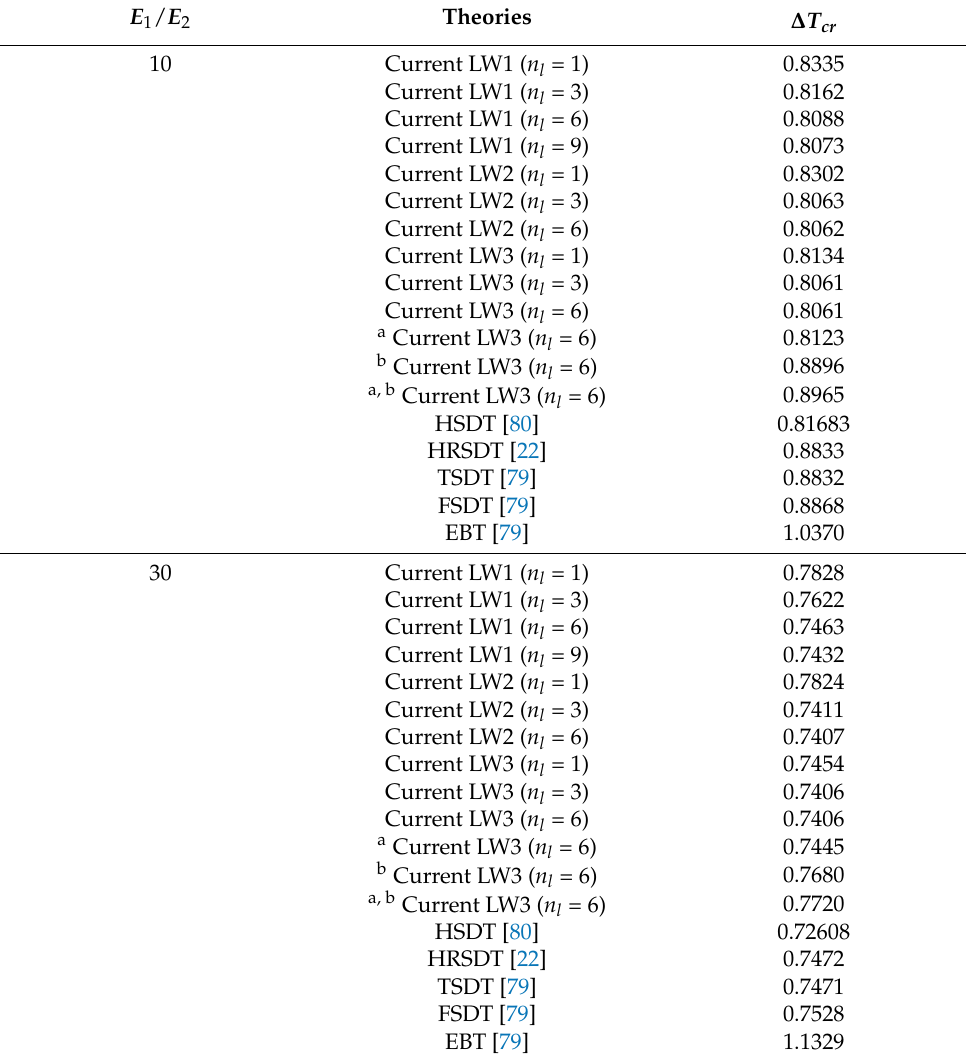
Table 2. Convergent study of critical temperature parameter solutions of simply supported, laminated (0 ◦ /90 ◦ /0 ◦ ) beams under a uniform temperature change ( α 2 / α 1 = 3, L / h =